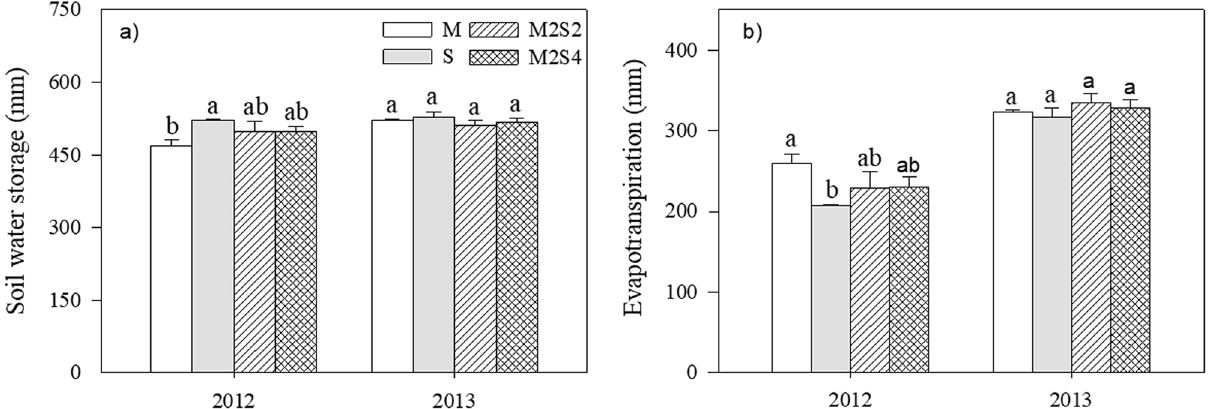
Figure 4. Soil water storage ( a ) and evapotranspiration ( b ) under sole cropping and intercropping systems. Bars are means + standard errors. Bars with different letters are significantly different between cropping systems for each year ( P < 0.05). M, sole-cropped maize; S, sole-cropped soybean; M2S2, two rows of maize intercropped with two rows of soybean; M2S4, two rows of maize intercropped with four rows of soybean.